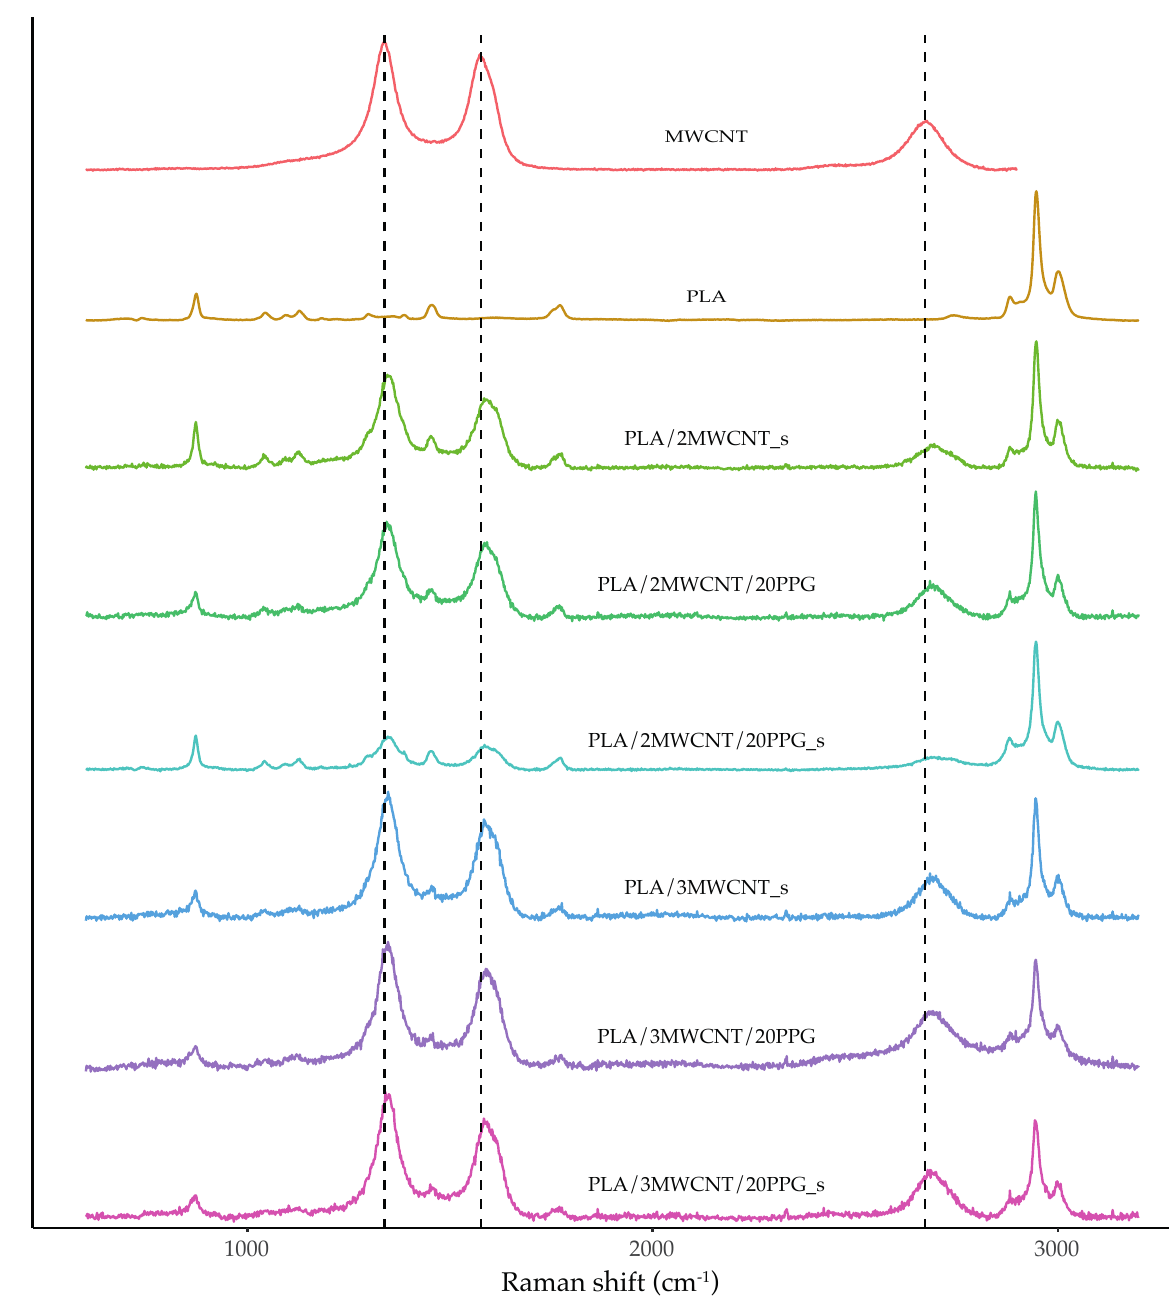
Figure 5. Raman spectra of neat PLA, composites, and pristine MWCNT. Dashed lines indicate MWCNT’s D, G, and 2D band